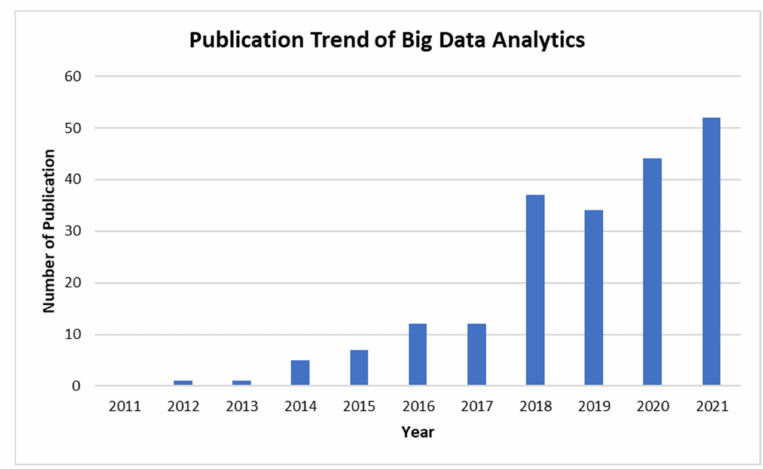
Figure 1. Publication Trend of BDA in SCM.